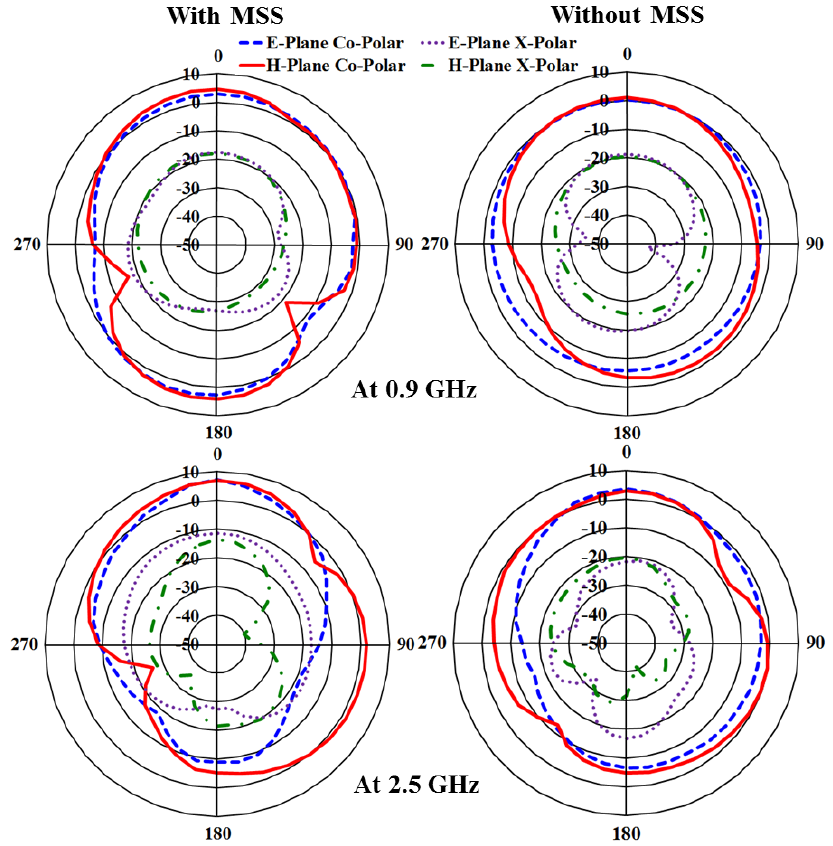
Figure 11. Measured radiation pattern of the antenna at both resonant frequencies with and without MSS.